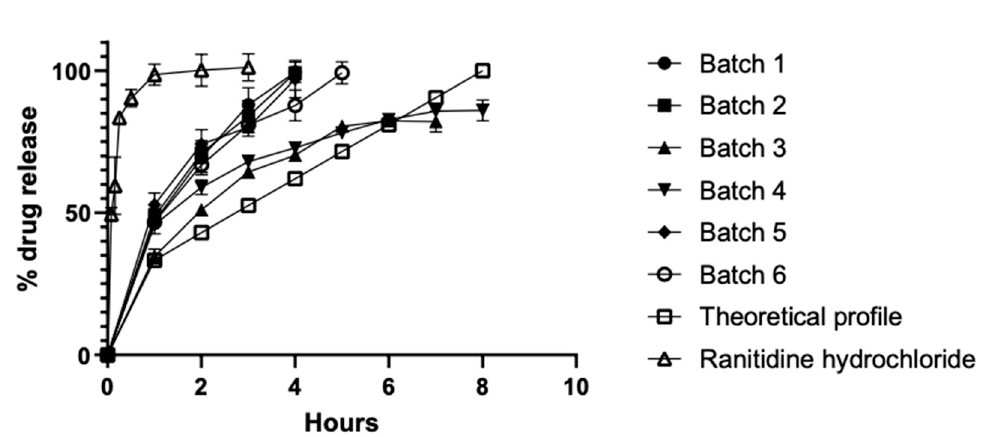
Figure 3. Drug release profile of ranitidine hydrochloride from different co-processed excipients.